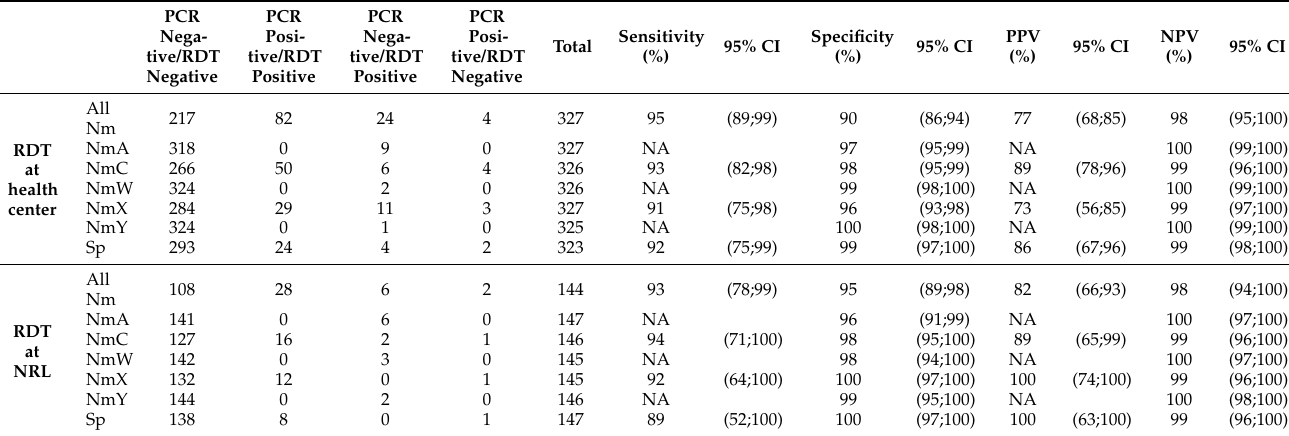
Table 2. Concordance of results obtained by RDT in PHCs and NRLs with results obtained by PCR in NRLs, and serogroup- specific performances, Burkina Faso and Niger, 2018–2019.